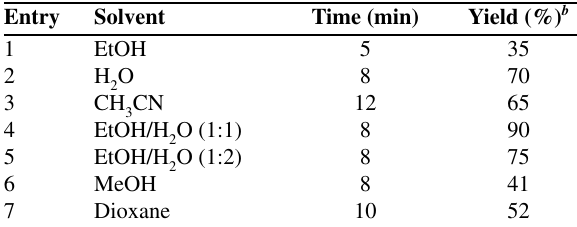
Table 3. Solvent effect on synthesis of 4a a